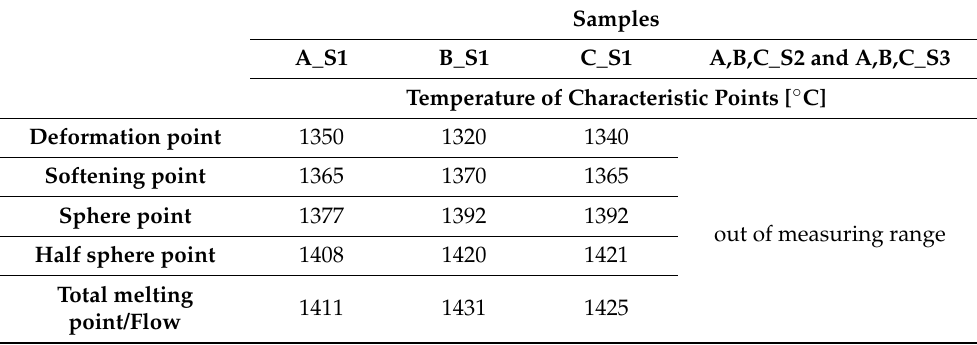
Table 3. Characteristic transformation points of reactive mixtures containing components of the cement-free corundum-spinel refractory castables and steel